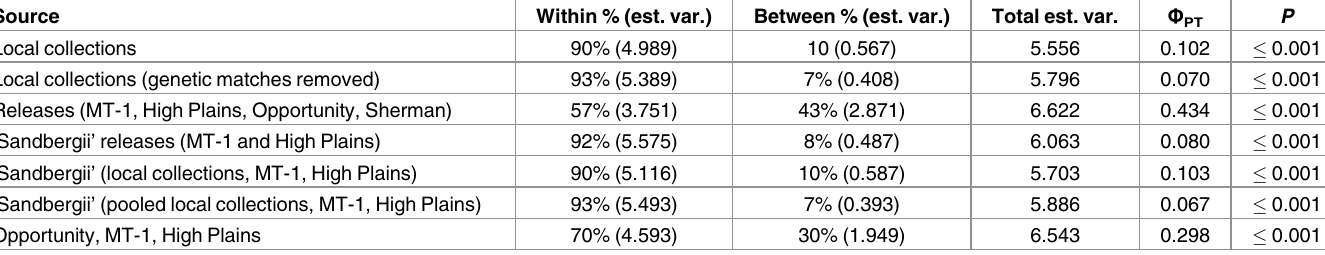
Table 4. Distribution of variation within and between Poa secunda source identities. Source Within % (est. var.) Between % (est. var.) Total est. var.